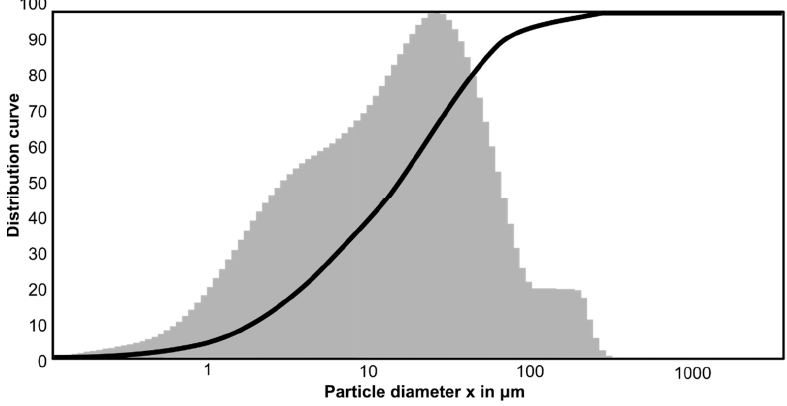
Figure 9. Particle size distribution of soot dust sample.